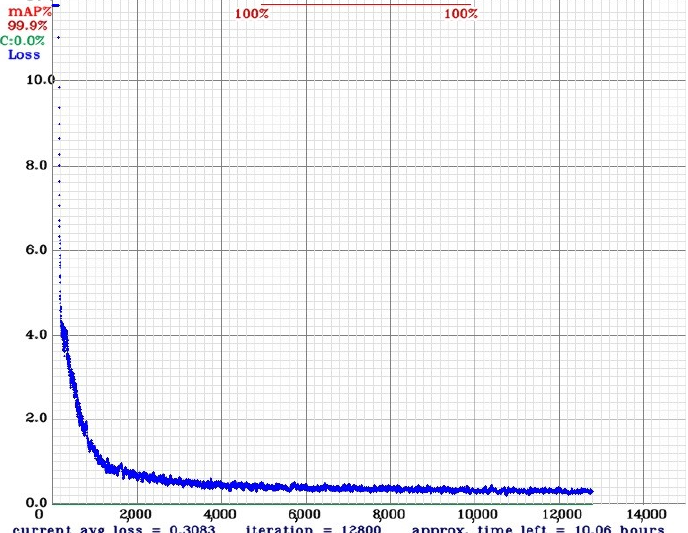
Figure 12. Average loss during the first 12 K iterations.